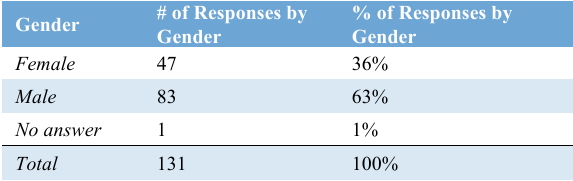
Table 4. Participants by